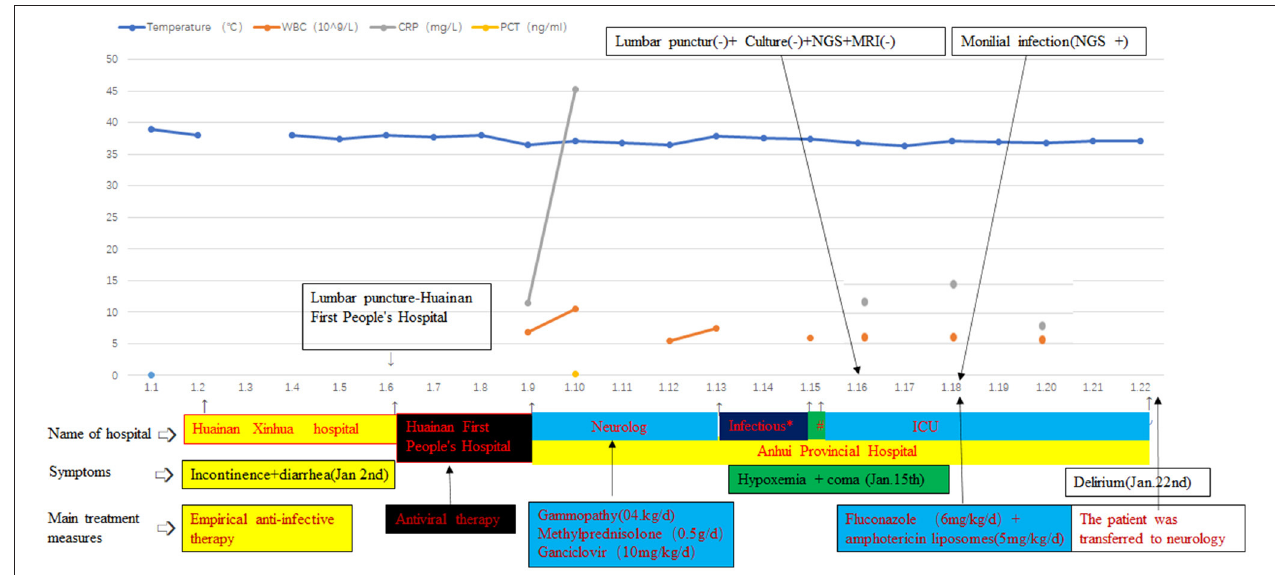
FIGURE 2 | Annotation: “*” indicated the department of infection; “#” indicated that the patient was treated in the neurology department in the afternoon and he was transferred to the intensive care unit (ICU) in the evening; “–” means negative; and “ + ” means positive. The beginning and end of each color bar indicated the treatment measures during this